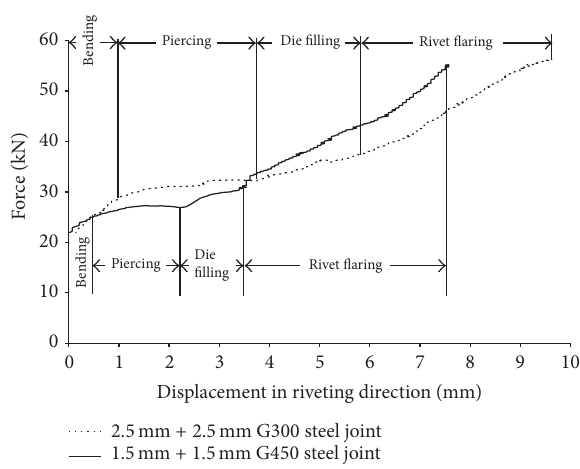
Figure 2: Physical events and SPR characteristics curves of the